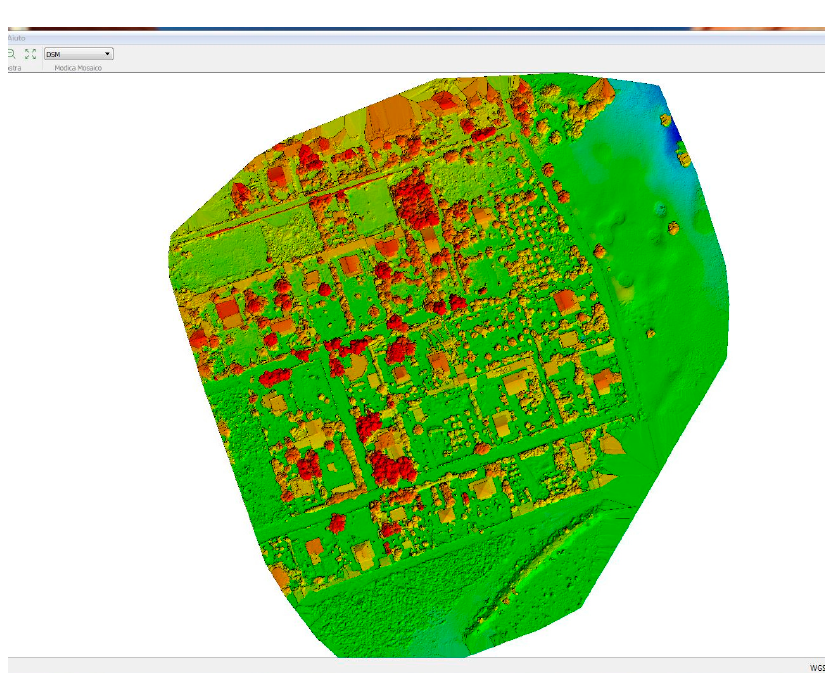
ISPRS Int. J. Geo-Inf. 2017 , 6 , 393